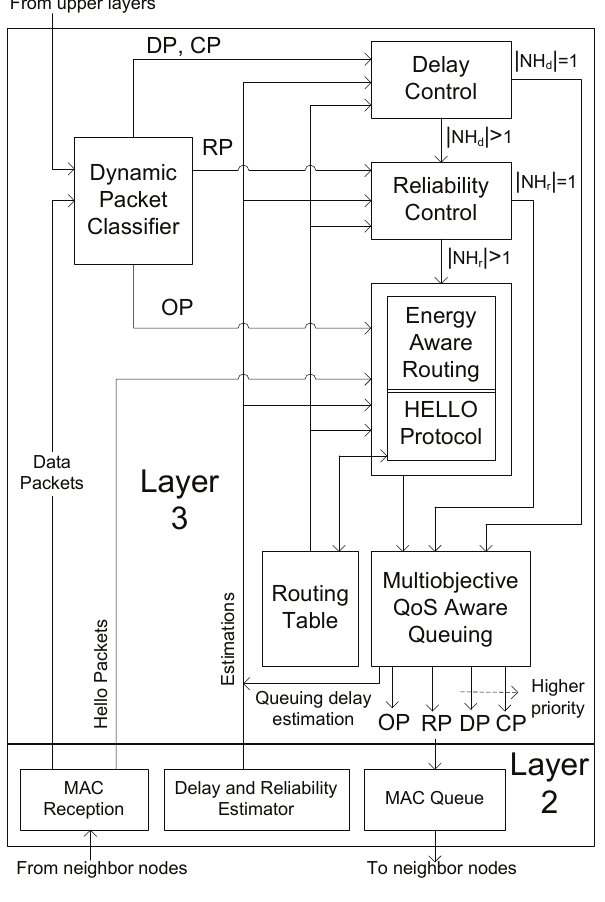
Figure 2. Data-centric multiobjective QoS-aware routing